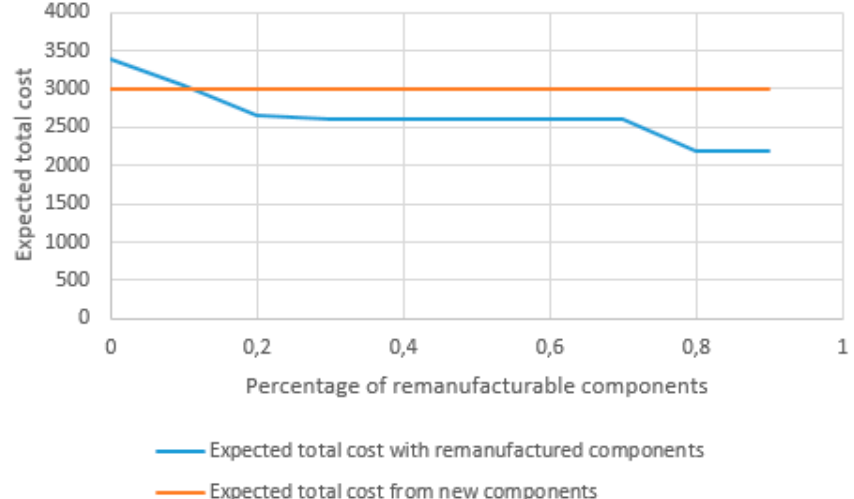
Figure 10. Sensitivity diagram of the percentage of remanufactured items.